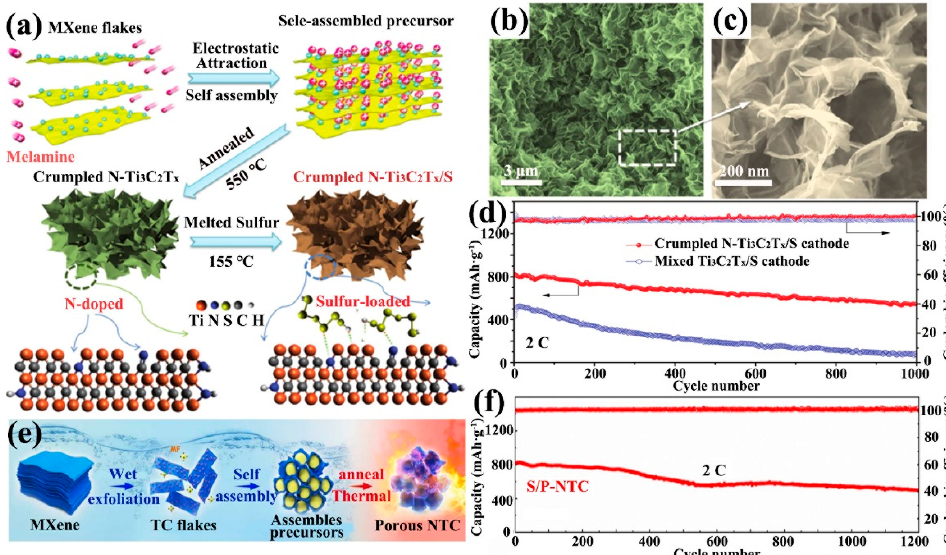
Figure 6. Preparation of crumpled N-Ti 3 C 2 T x /S cathode ( a ), SEM images ( b , c ) and its 1000 cycles test at 2C ( d ) [95]. Copyright 2018, John Wiley and Sons. Synthesis diagram of P-NTC ( e ) and 1200 cycles of S/P-NTC test at 2C ( f ) [96]. Copyright 2020, Elsevier.